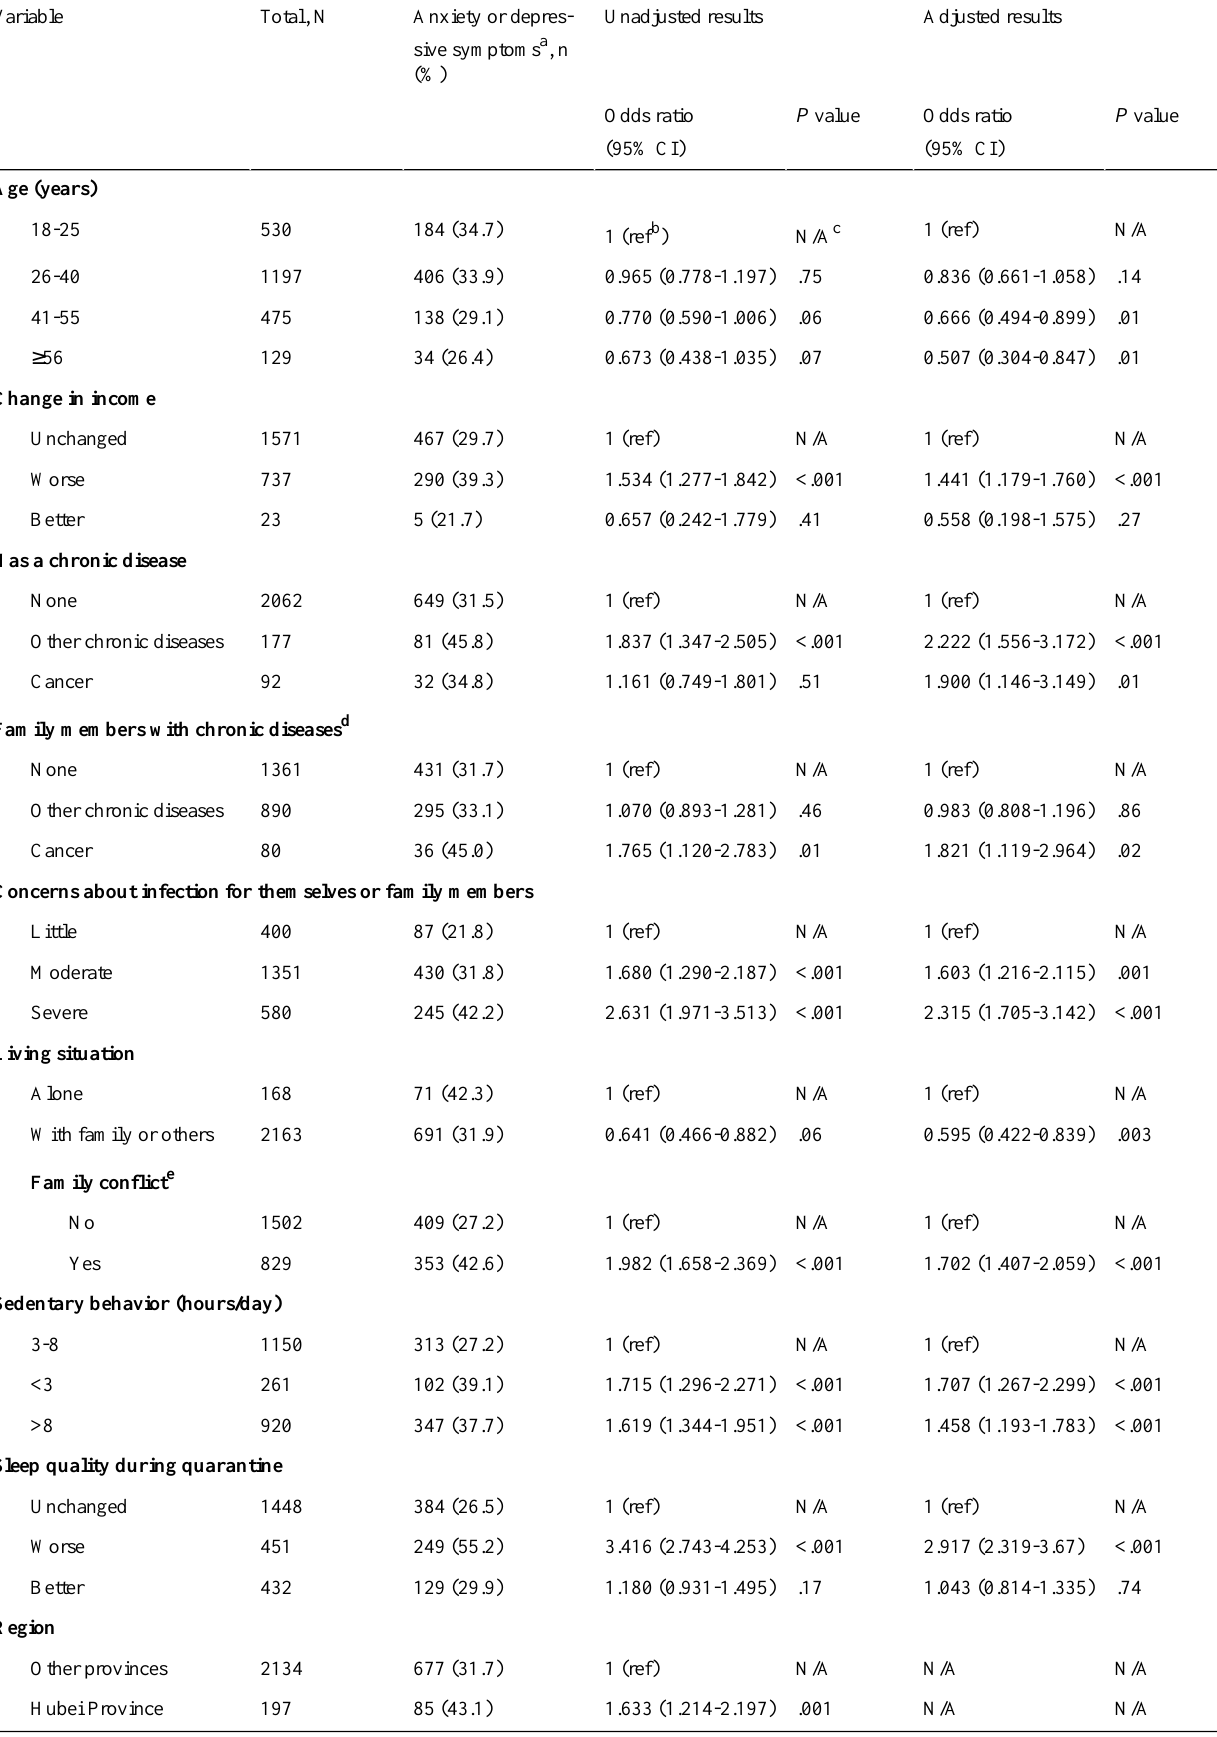
Table 1. Logistic regression of associated factors for elevated anxiety or depressive symptoms during the quarantine